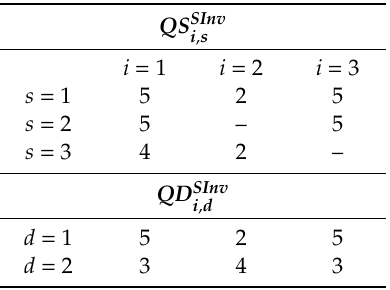
Table A26. Safety inventory level (units).